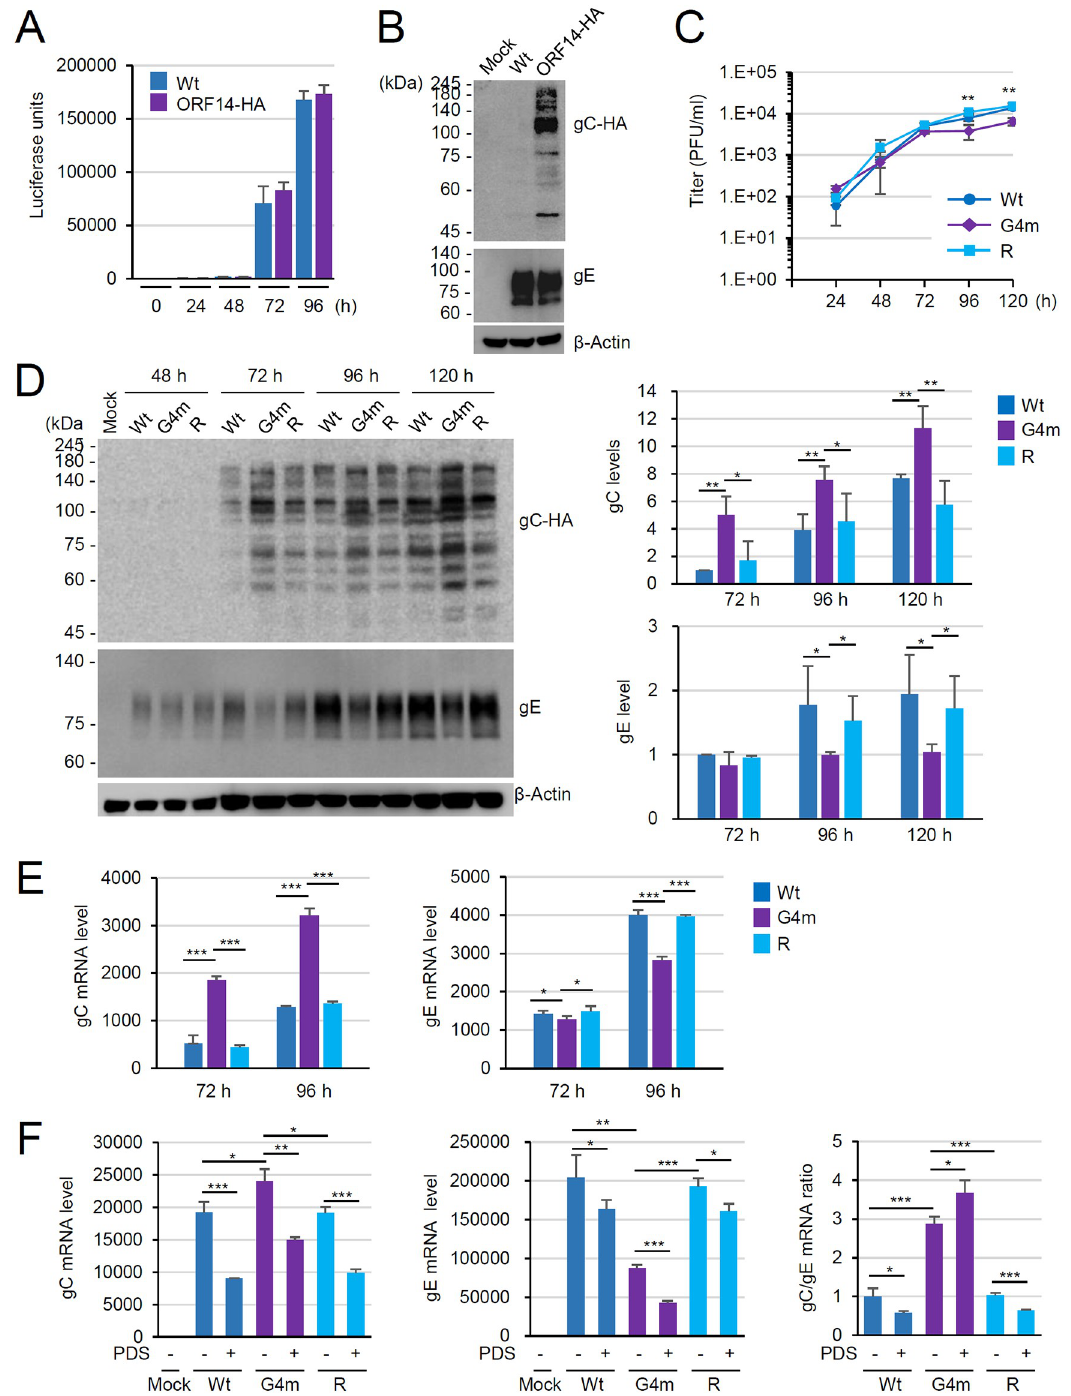
Fig 8. Altered gC expression in the recombinant virus containing the G4-disrupted ORF14-HA gene. (A) HF cells were infected with recombinant pOka viruses containing the wild-type ORF14 or ORF14-HA gene at an MOI of 0.01. Cells were harvested at 24, 48, 72 and 96 h after infection and luciferase activities in cell lysates were measured. Results are shown as mean values and standard errors of three independent experiments. (B) HF cells were infected with recombinant viruses (wild-type or ORF14-HA) at an MOI of 0.01 Total cell lysates were prepared at 96 h after infection and subjected to SDS-PAGE and immunoblotting with ant-HA and anti-gE (ORF68) antibodies. Levels of β -actin are shown as a loading control. (C) HF cells in 12-well plates were infected with recombinant pOka viruses [wild-type, G4-disrupted mutant (G4m), and its revertant (R)] at an MOI of 0.001. Cells were harvested at